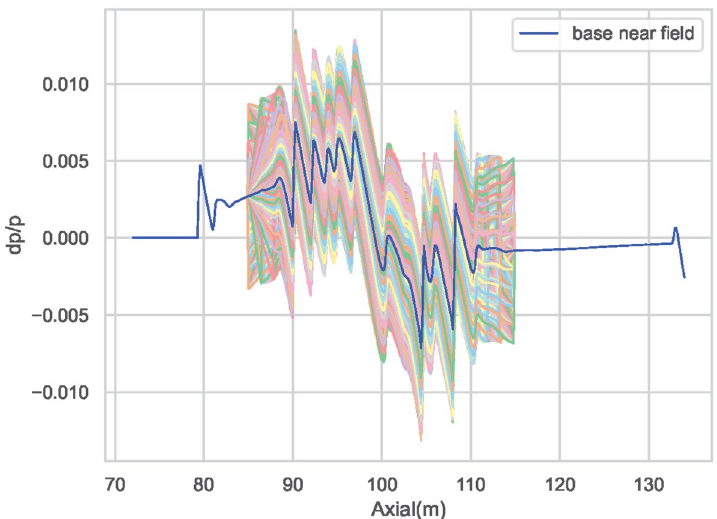
Fig. 11 Near-field data